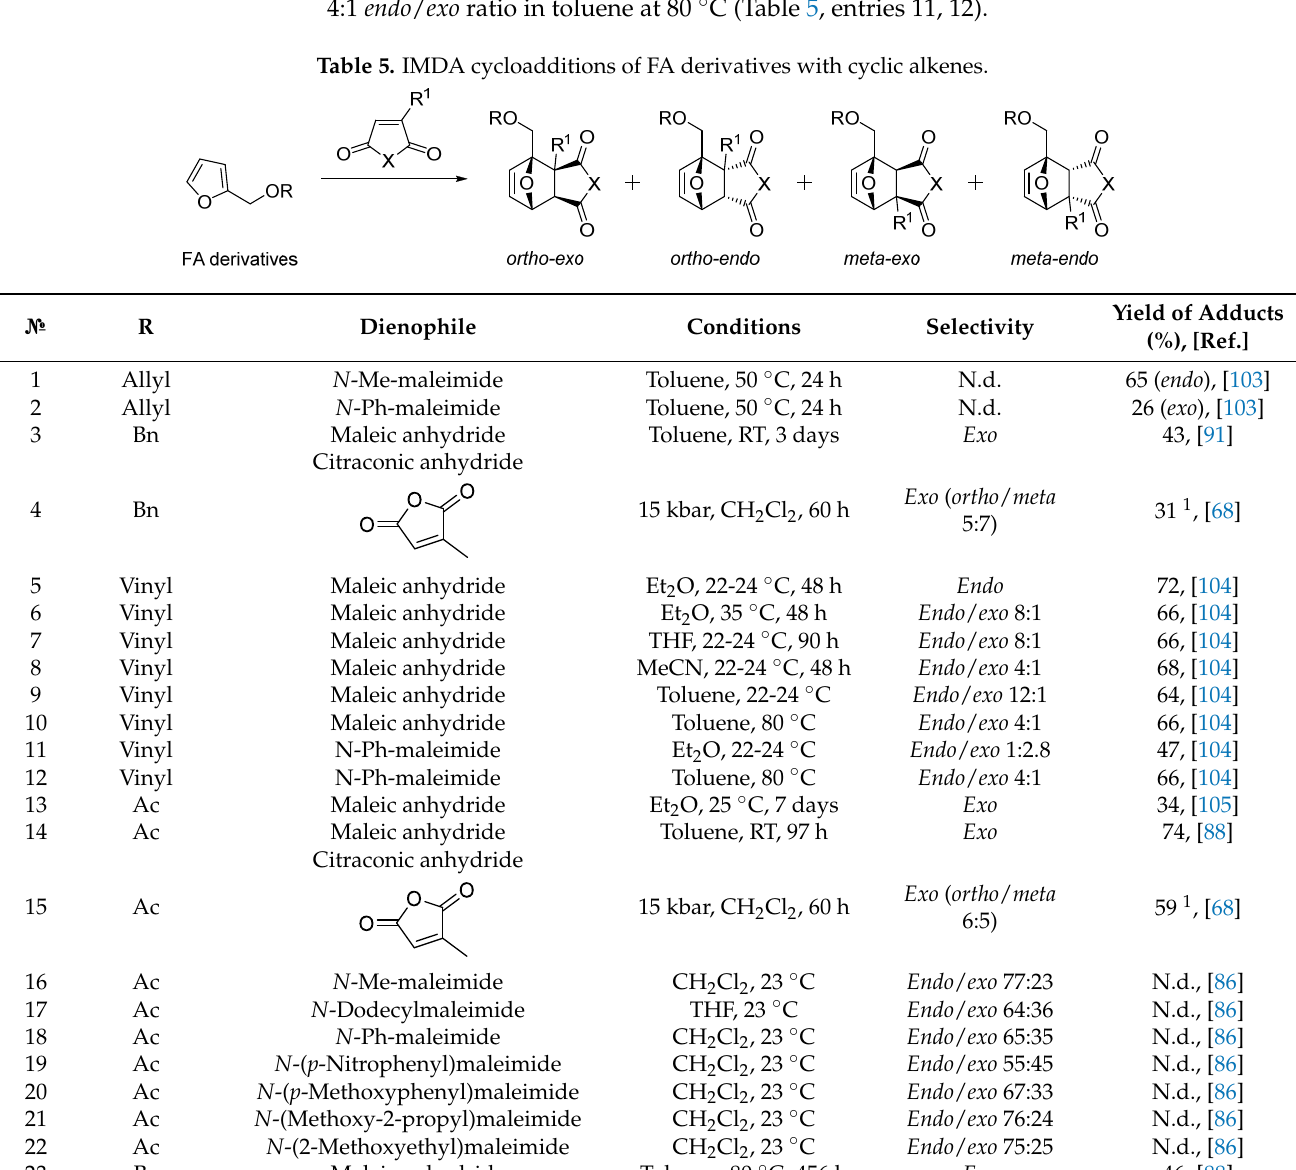
Table 5. IMDA cycloadditions of FA derivatives with cyclic